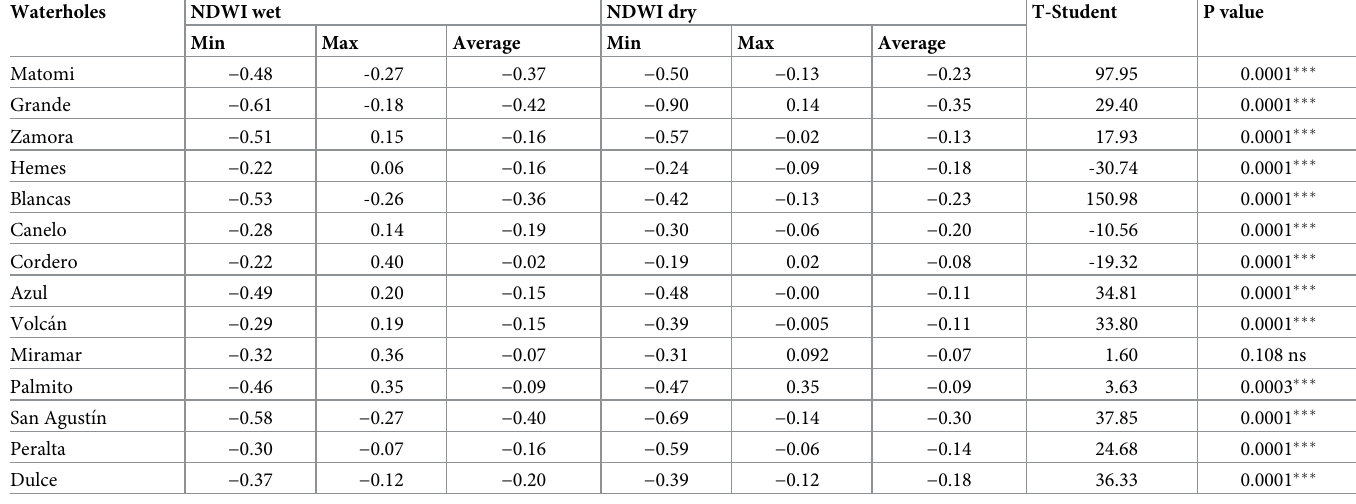
Table 3. Comparison of NDWI values during the wet (November to February) and dry (May to July) seasons using paired t-test in Sierra Santa Isabel, Baja Califor- nia, Mexico. Waterholes